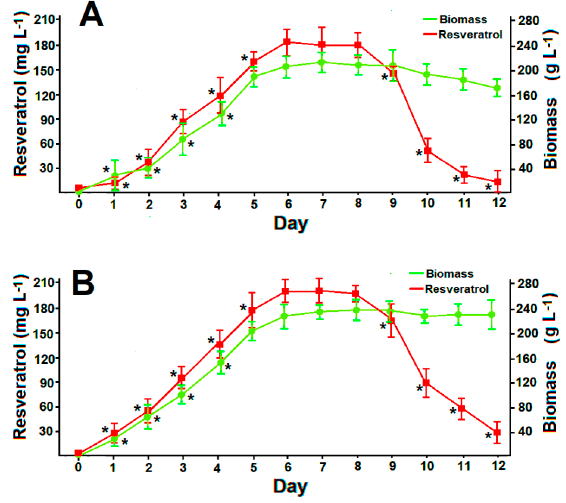
Figure 5. Effects of 200 mg L − 1 PHE ( A ) and 200 mg L − 1 TYR ( B ) on the growth of Arcopilus aureus MaC7A and its RV production in batch cultures. * Indicates statically significant differences ( p < 0.05) for RV production and biomass compared with that of day 6. Error bars represent SD (n = 10).